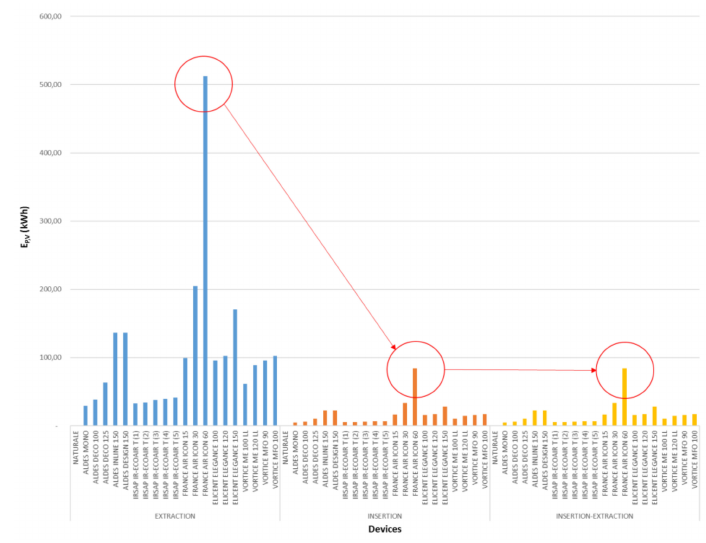
Figure 9. Values of E P,V for the three systems of CMV. NB: all the figures use dots and commas as per Italian standards.